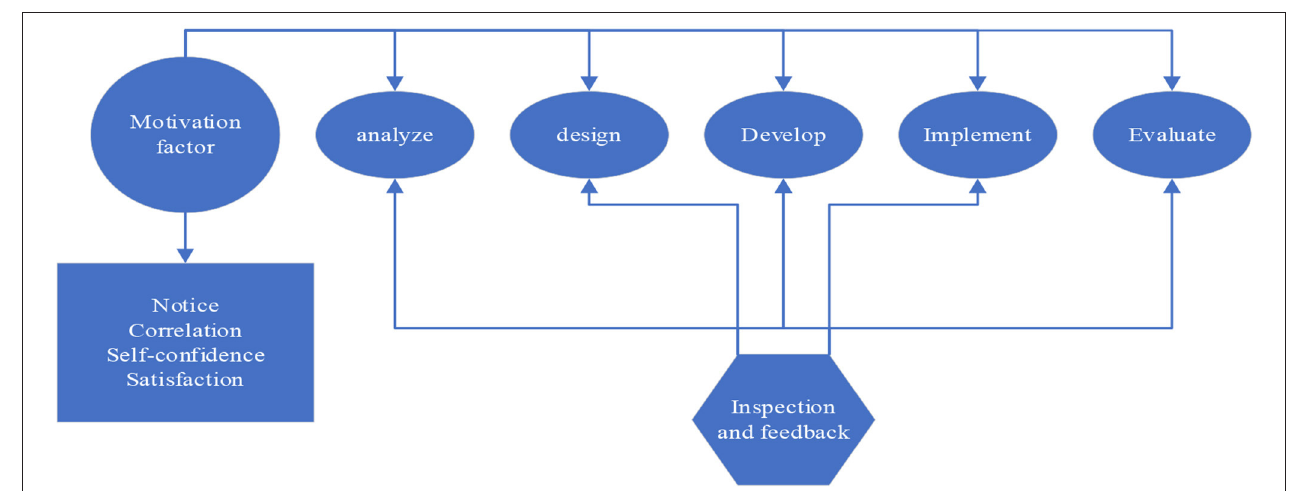
FIGURE 6 | Integration of